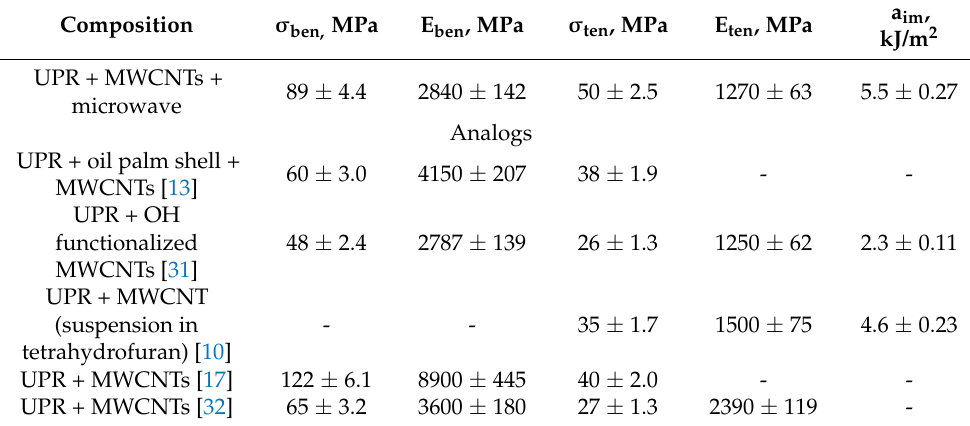
Table 5. Comparison of developed composites with